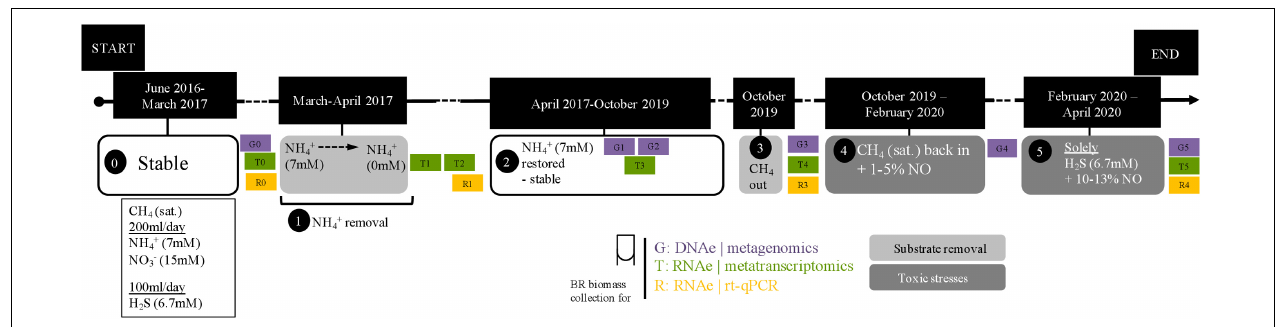
FIGURE 1 | Timeline of experiments. Zero indicates when the bioreactor was stably maintained; 1, period of the ammonium removal experiment; 2, after the ammonium removal experiment and restabilization period; 3, reactor moved into a fume hood in preparation for the next experiment; 4, preparatory period for the nitric oxide and sulfide toxicity stresses experiment; 5, nitric oxide and sulfide toxicity stresses experiment. Samples for metagenomics (G0–G5), metatranscriptomics (T0–T5), and RT-qPCR (R0–R1 and R3–R4) were collected as indicated across experimental time points and in between them. The dashed line in the ammonium removal experiment indicates that removal was conducted stepwise (in mM: 7 → 4.5 → 3.5 → 2.5 → 0). Exact dates and experiment durations are provided in Supplementary Table 1 .